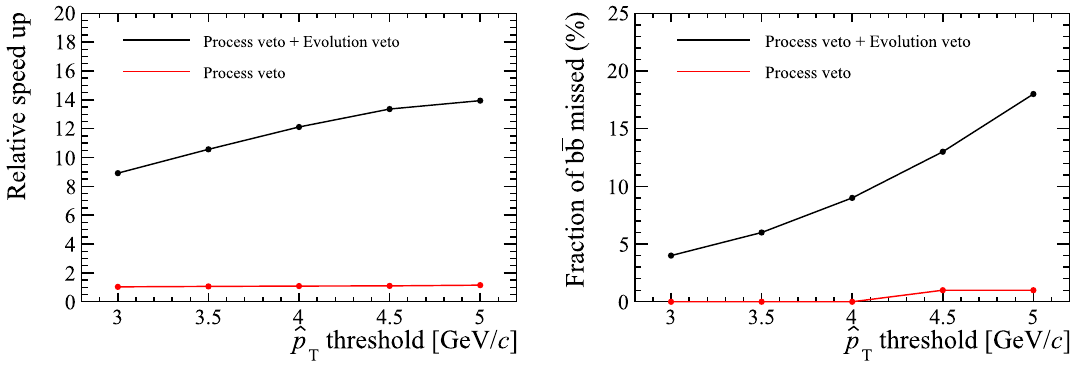
Fig. 6 (Left) Relative speed enhancements of Pythia when generating b ¯ b events with process-level and evolution-level UserHooks . (Right) The fractions of b ¯ b events that are not retained by the UserHooks as a function of ˆ p T